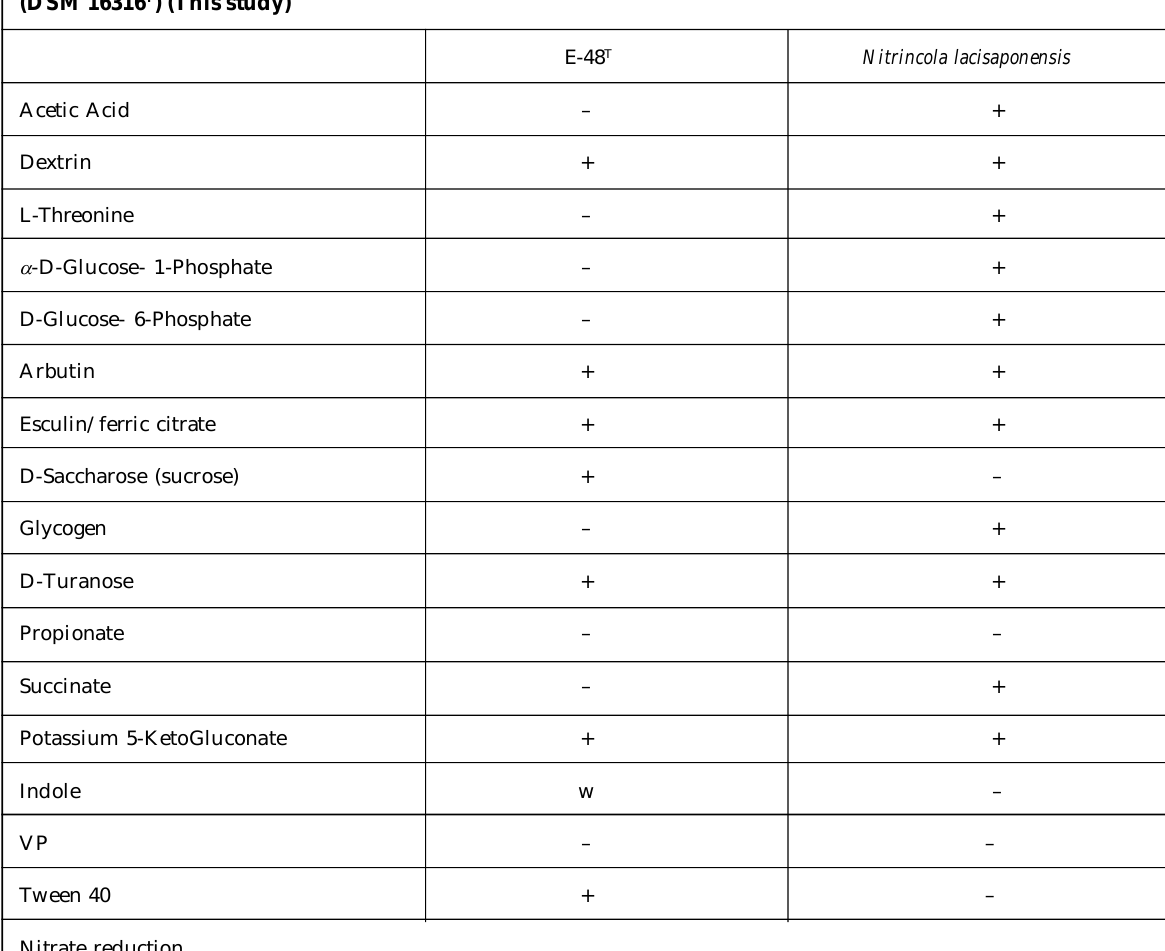
Table 1b: Biochemical characteristics of the Isolates E-48 T and Nitrincola lacisaponensis (DSM 16316 T ) (This study)